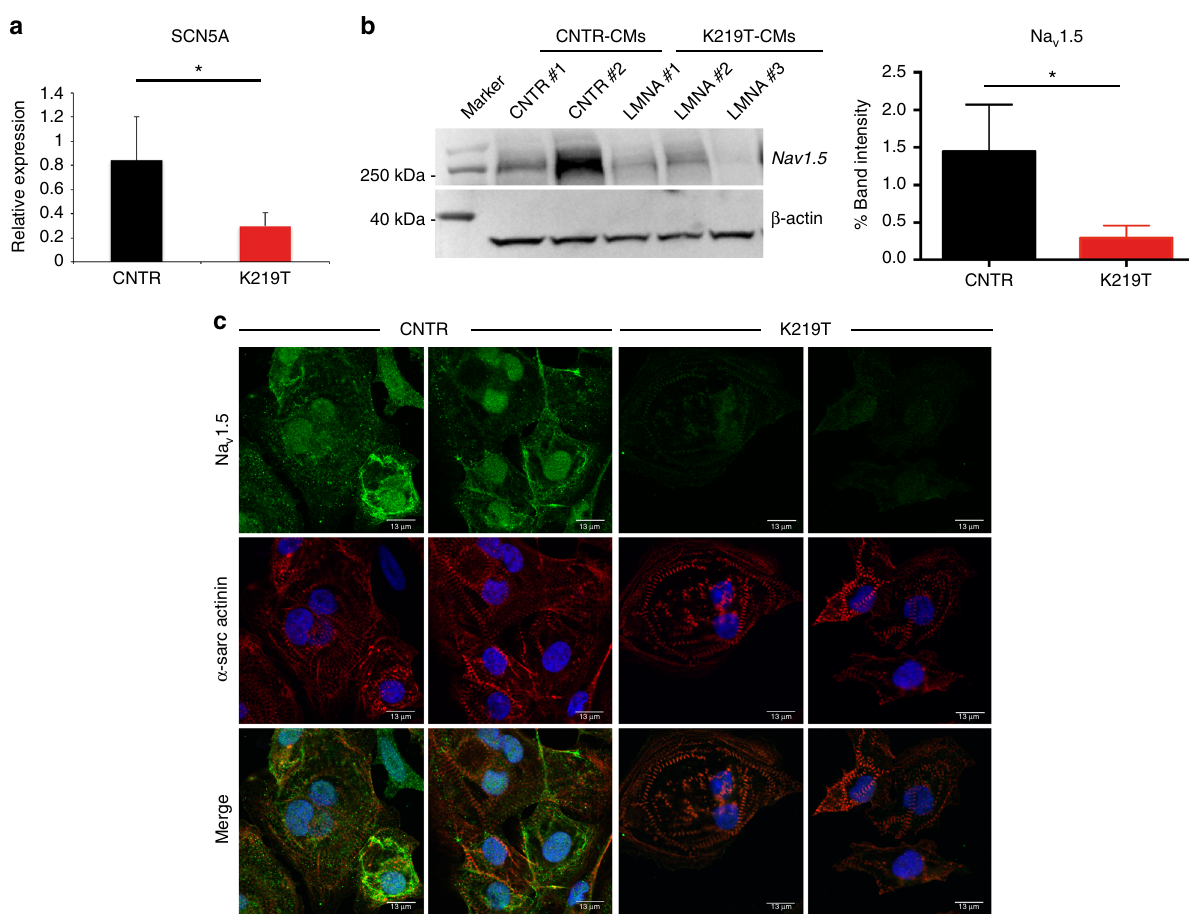
Fig. 4 Reduced sodium current density is dependent upon reduction of SCN5A expression. a RT-qPCR showing reduced expression of SCN5A gene in CMs generated from K219T-LMNA-iPSCs vs those differentiated from CNTR lines. Data are represented relative to CNTR-CMs and normalized for expression of the housekeeping genes 18S and HGPRT . Data are relative to CMs differentiated from 2 independent lines from 2 CNTR and 3 K219T-LMNA subjects. b Left: Representative Western blot showing reduced Na v 1.5 channel expression in K219T-CMs. Data are representative of one cell line per subject. Right: Na v 1.5 expression quanti fi cation in CNTR-CMs and K219T-CMs, calculated as densitometric Na v 1.5 / β -actin ratio (the diagram represents the mean of three independent experiments). c Representative immuno fl uorescence images for Na v 1.5 (green) and α -sarcomeric actinin (red) in CNTR-CMs and K219T-CMs; nuclei are stained with DAPI (Scale bars: 13 μ m). A decrease in the expression of Na v 1.5 in K219T-CMs vs. CNTR-CMs is evident. All values are reported as mean ± SD. * p < 0.05 (unpaired t